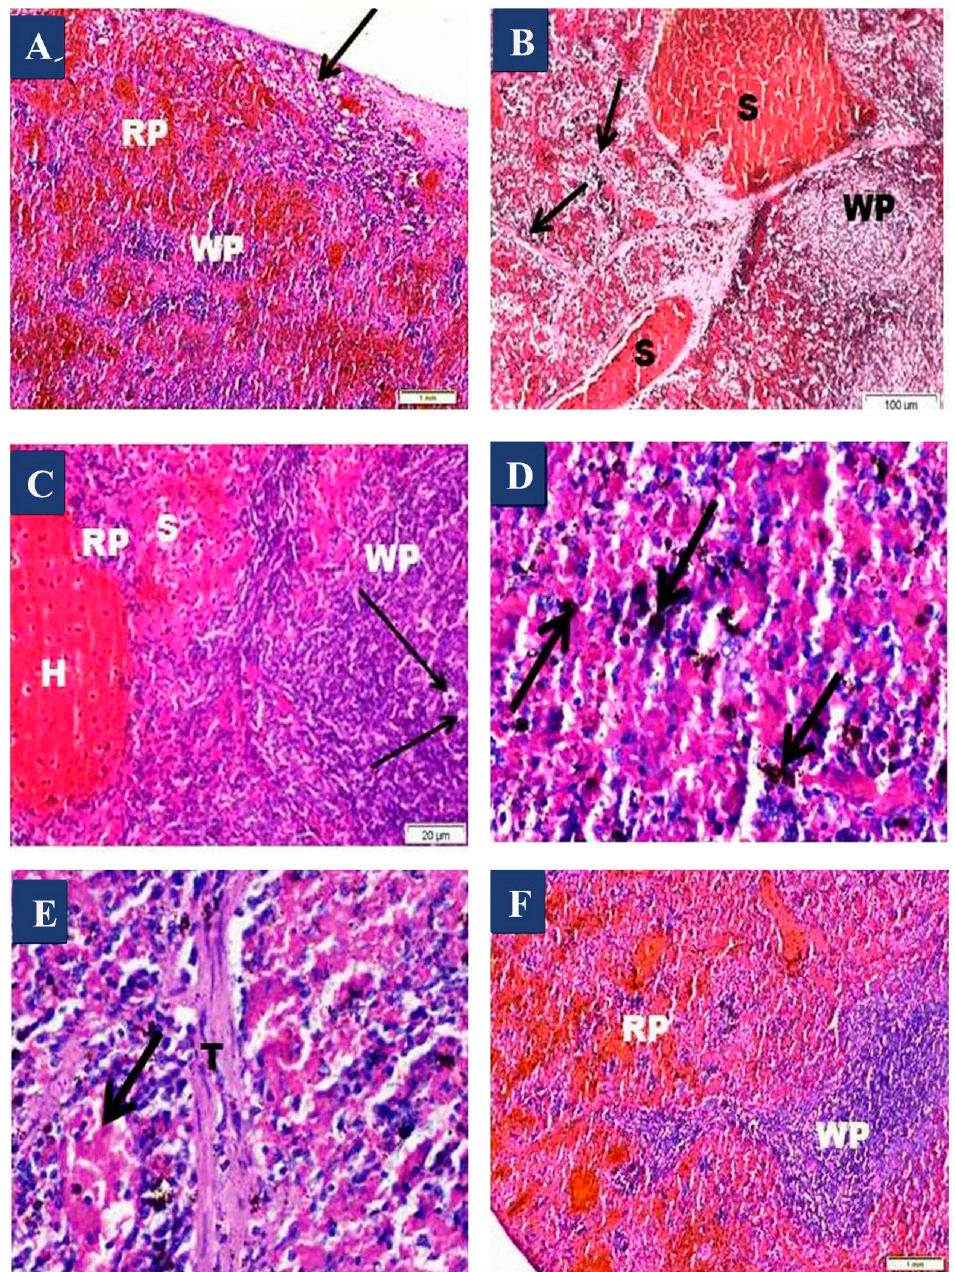
Figure 2. Photomicrographs of haematoxylin and eosin stained sections of the spleen from group (III) and group (IV). ( A ) Olanzapine-treated group showing loss of normal architecture and highly shrunken white pulp (WP) and broadened red pulp (RP). Note the massive area of vacuolations (arrow). ( B ) The Olanzapine-treated group showing congested dilated splenic sinuses (S) in the red pulp. Many cells in the white pulp (WP) appear vacuolated. Note, thick fibrous trabeculae is observed (arrows). ( C ) The Olanzapine-treated group showing some cells that appeared vacuolated with fragmented nuclei (arrows) in white pulp (WP), massive hemorrhage (H) in the red pulp (RP), and dilated sinusoids (S). ( D ) Olanzapine group showing hemosiderin laden cells (arrows). ( E ) Olanzapine group showing thickened trabeculae (T) and markedly dilated congested splenic sinus (arrow). ( F ) Vitamin C and olanzapine group showing nearly normal appearance of the splenic architecture of white pulp (WP) and red pulp (RP). ( A , B , F ) H&E, × 100; ( C – E ) H&E, ×